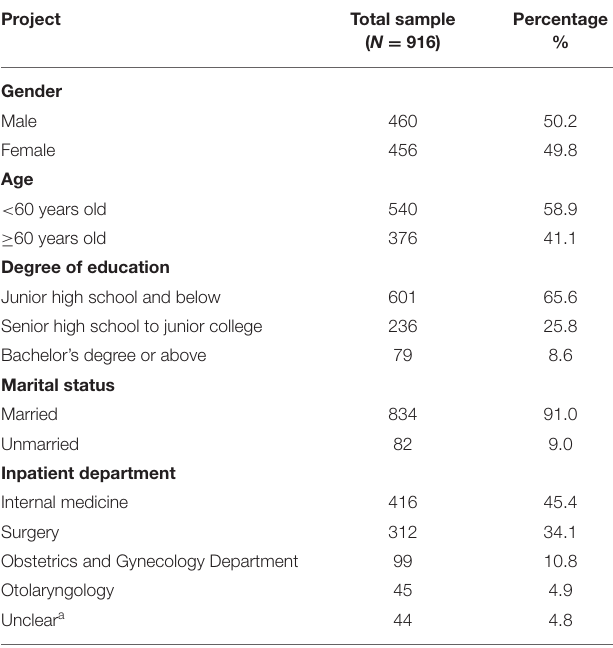
TABLE 1 | Demographic characteristics of the